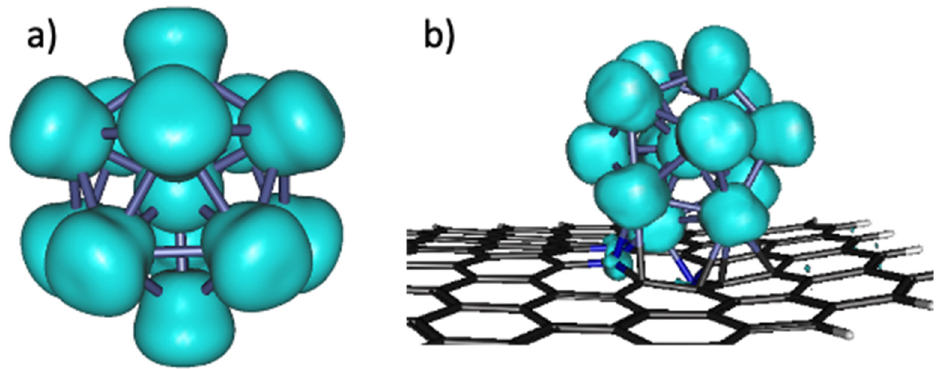
Figure 3. Spin density distributions of the systems: ( a ) Co 13 nanocluster and ( b ) Co 13 /PNG compo-